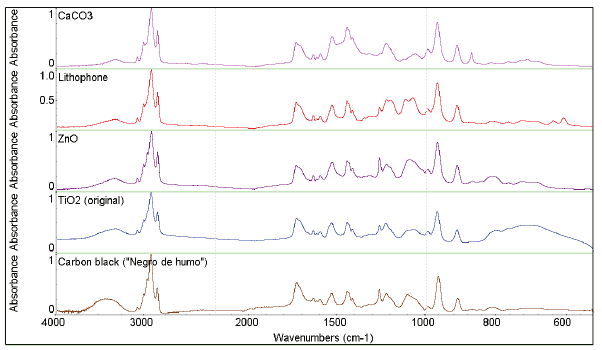
Figure 1: FT-IR spectra for five HTPB-based polyurethane microcomposites with different mineral fillers at 20% (w/w).